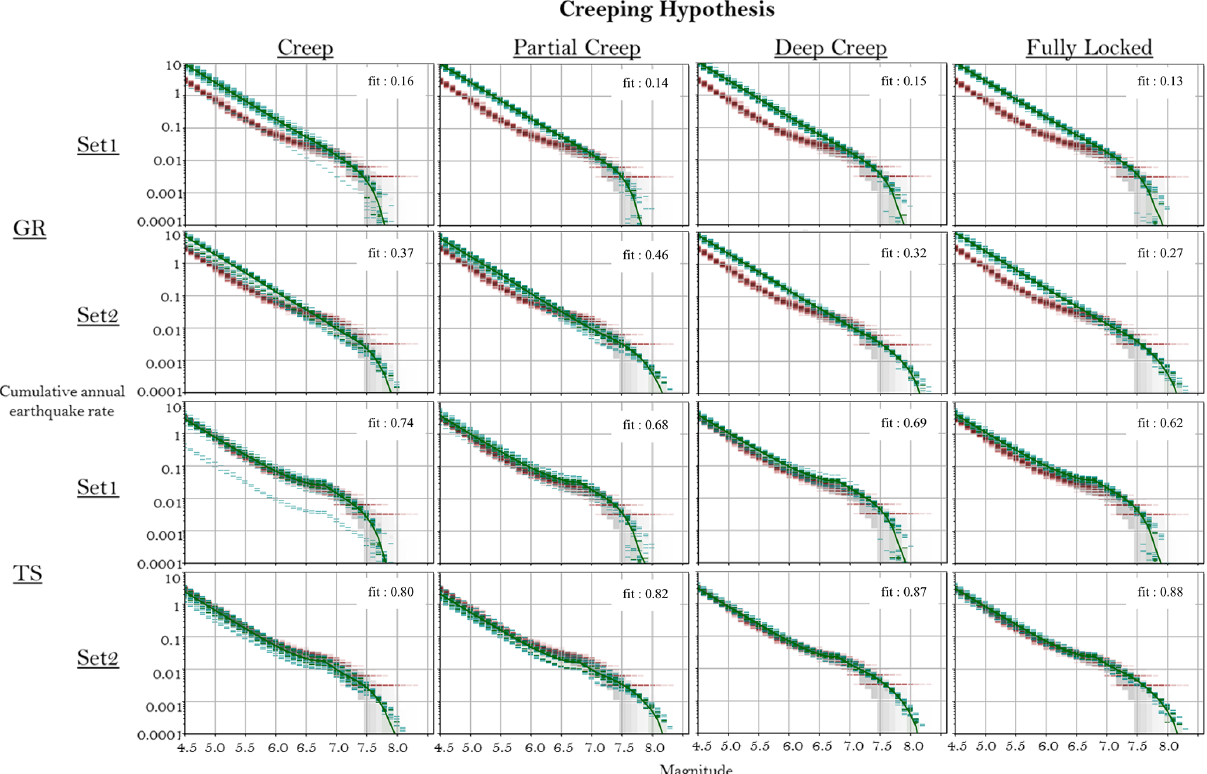
Figure 7. Comparison between the rates calculated from the earthquake catalogue (in red with uncertainties in grey) and the model rates (in green) for the central zone of the fault system, close to Istanbul (Fig. 2). The dashed green lines are the MFD for each individual model of the logic tree. The dotted green lines are the 16th and 84th percentiles of the distribution, and the continuous green line is the mean value of the distribution. Each figure shows the match between model and data for each branch of the logic tree, organized as a table. A fit of 1 is a perfect fit, and a value close to 0 expresses a very poor